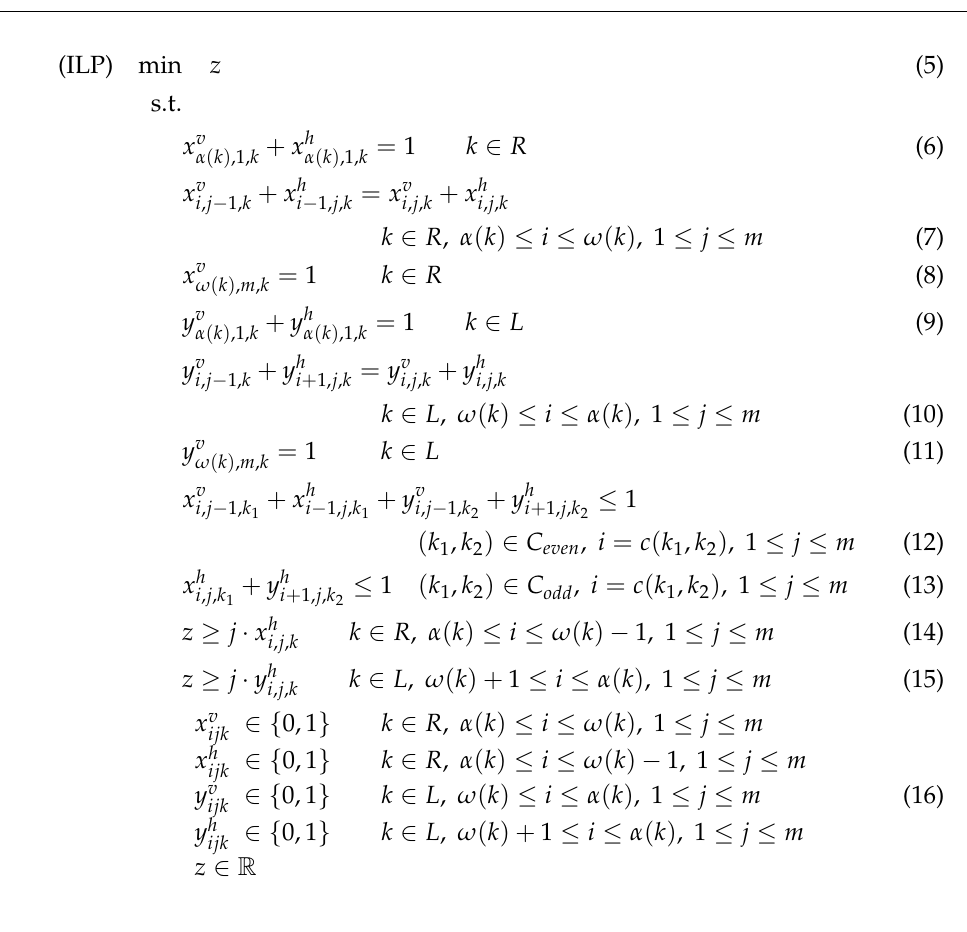
Figure 2. The integer linear programming formulation of FQRP-G